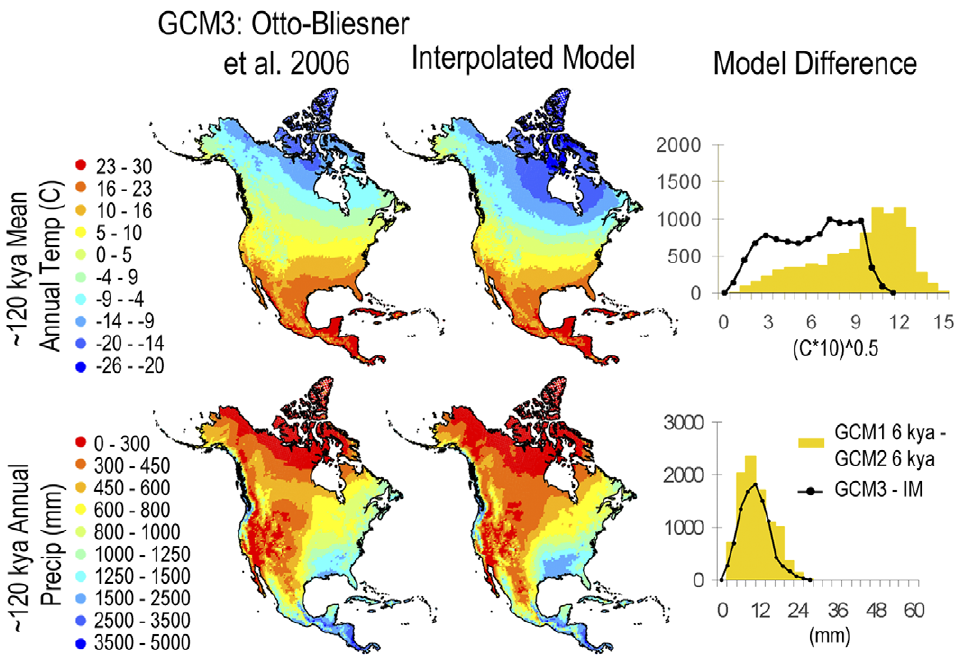
Figure 4. Mean annual temperature and annual precipitation modeled for , 120 kya. One GCM and an interpolation model (IM) are compared. Graphs at the right show differences between our model and the GCMs (line) with the differences between the two 6 kya GCMs for comparison (yellow bars).